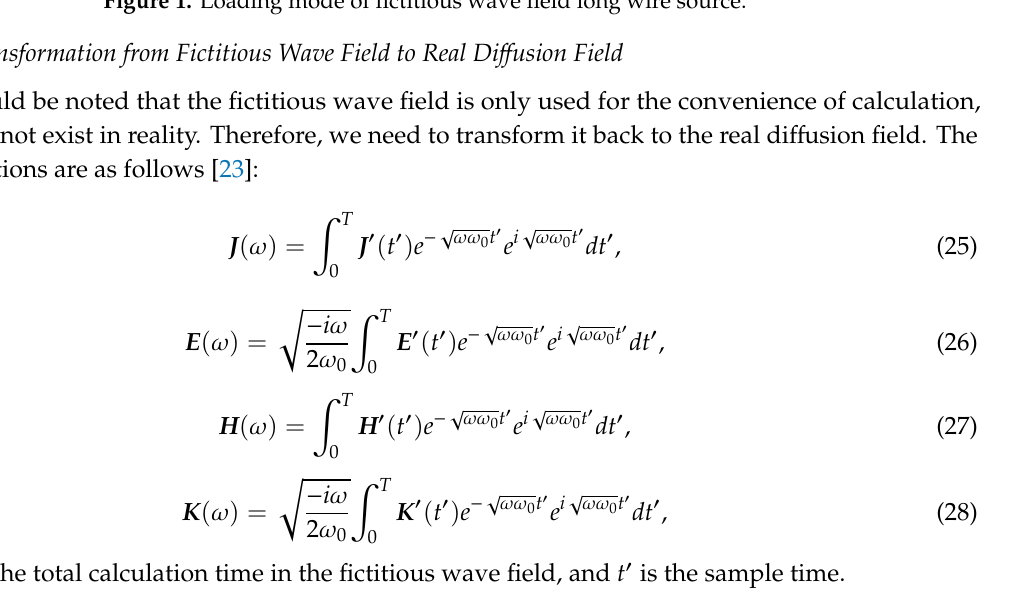
Figure 1. Loading mode of fictitious wave field long wire source.